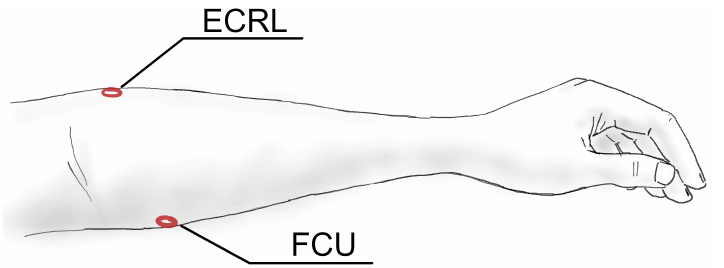
Figure 3. The locations of the sensors on the forearm during acquisition of the signals for the